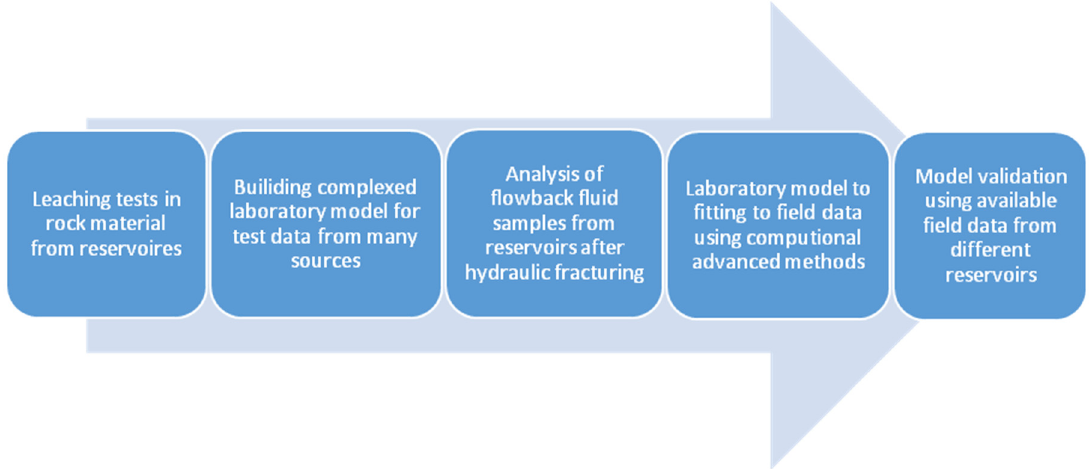
Figure 3. Possible directions of further studies on the development of proposed model.